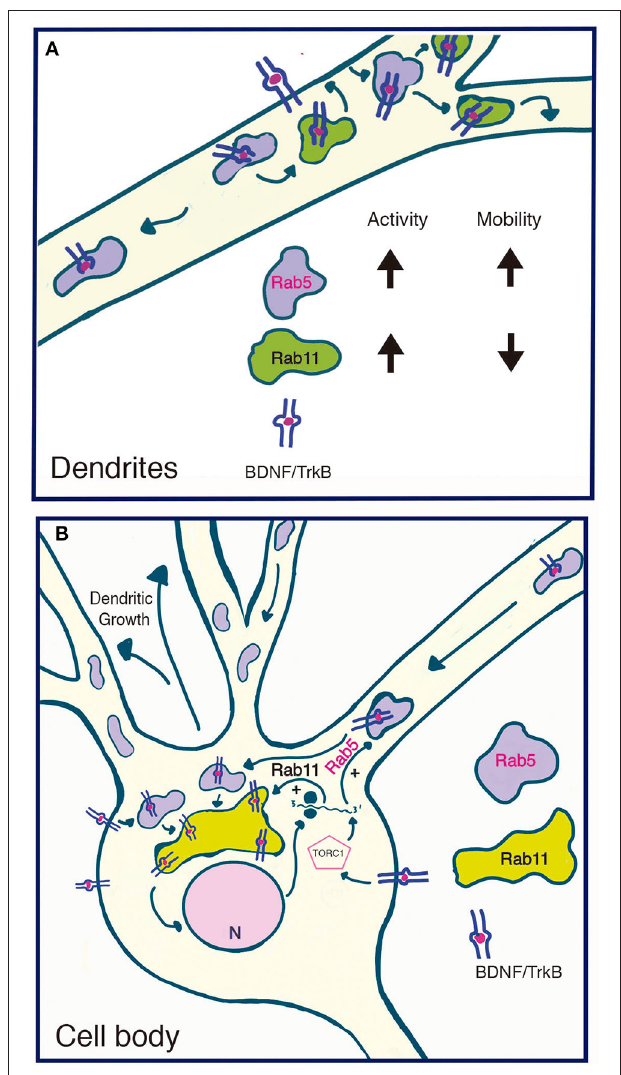
FIGURE 10 | Model summarizing the functional relationship between the early recycling pathway and BDNF/TrkB signaling. (A) In dendrites, BDNF increases the activity and reduces the mobility of Rab11-endosomes, fostering the local recycling of TrkB in dendrites and increasing local BDNF signaling (Lazo et al., 2013). On the other hand, BDNF transiently increases the activity of Rab5, a process that increases the number and mobility of Rab5 endosomes in dendrites. Since Rab5 early endosomes are upstream of Rab11 recycling endosomes, increased activity of Rab5 may, on the one hand, foster the Rab11-dependent recycling of TrkB in dendrites and, on the other hand, increase the transport of Rab5 endosomes to the soma. (B) In the soma, increased activity of both Rab5 (this paper) and Rab11 (Lazo et al., 2013) by BDNF may increase the cell body recycling of TrkB, increasing the long-lasting signaling of BDNF required for dendritic growth. Increased activity of the TORC1 complex by BDNF increased the protein levels of Rab5 and Rab11 acting as a positive feedback loop that contributes to BDNF-induced dendritic